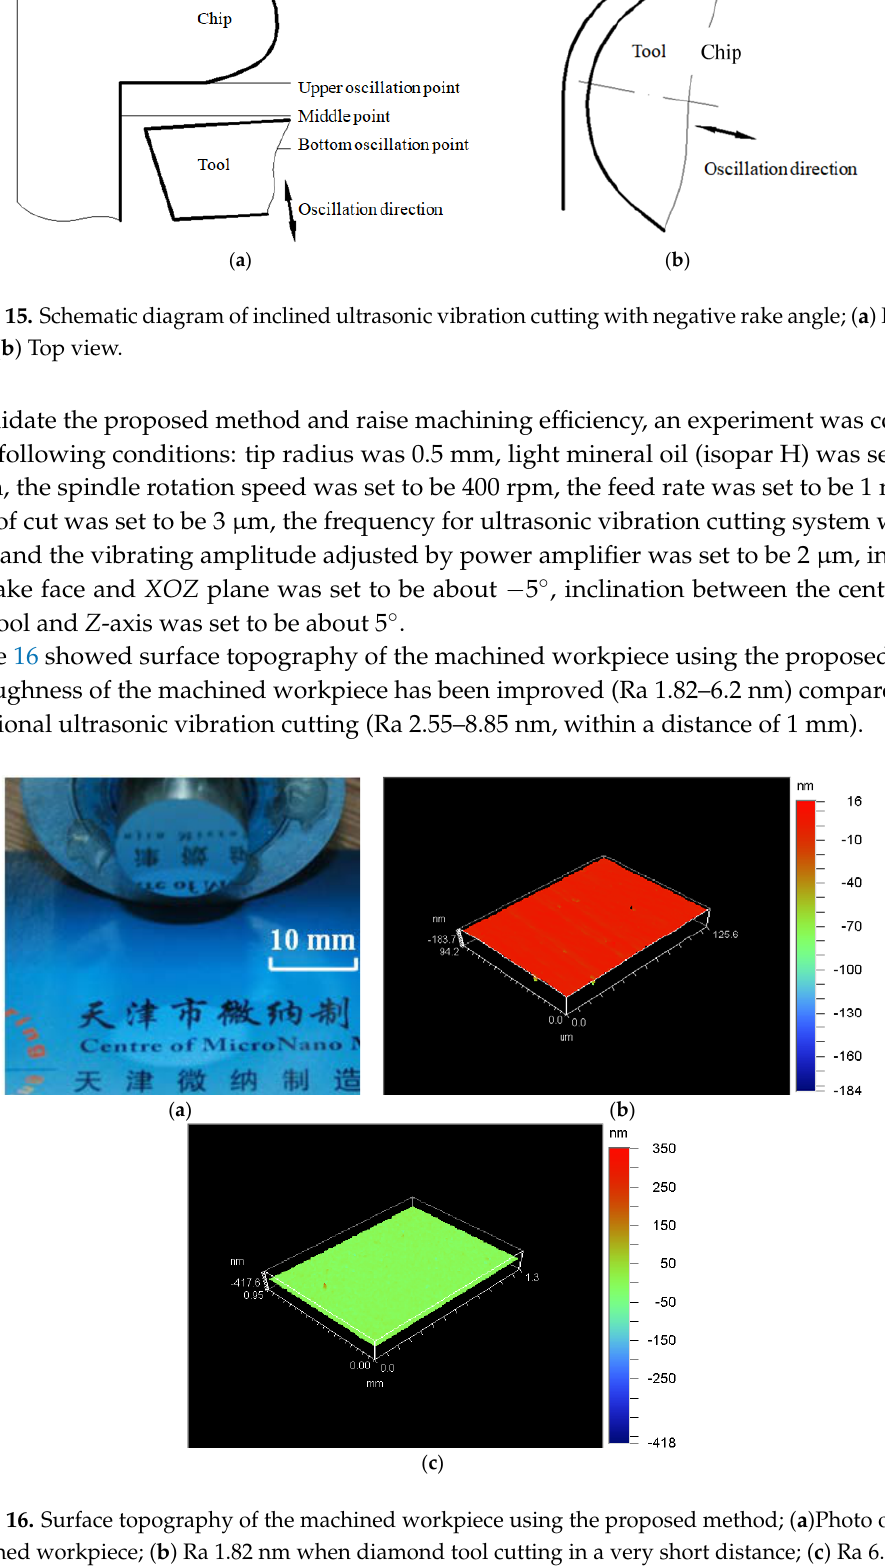
Figure 17. Wear of diamond tool with tip radius of 0.5 mm after cutting along X -axis with negative rake angle (wear land width: 0.78 µm, wear land length: 41.47 µm).